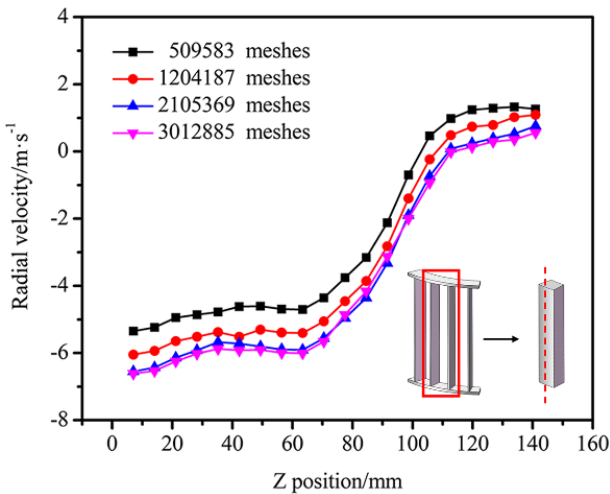
Figure 3. The radial velocity for four different mesh numbers. Table 2. Mesh number of the model and near-wall grid height for the new rotor-type dynamic clas- sifier.